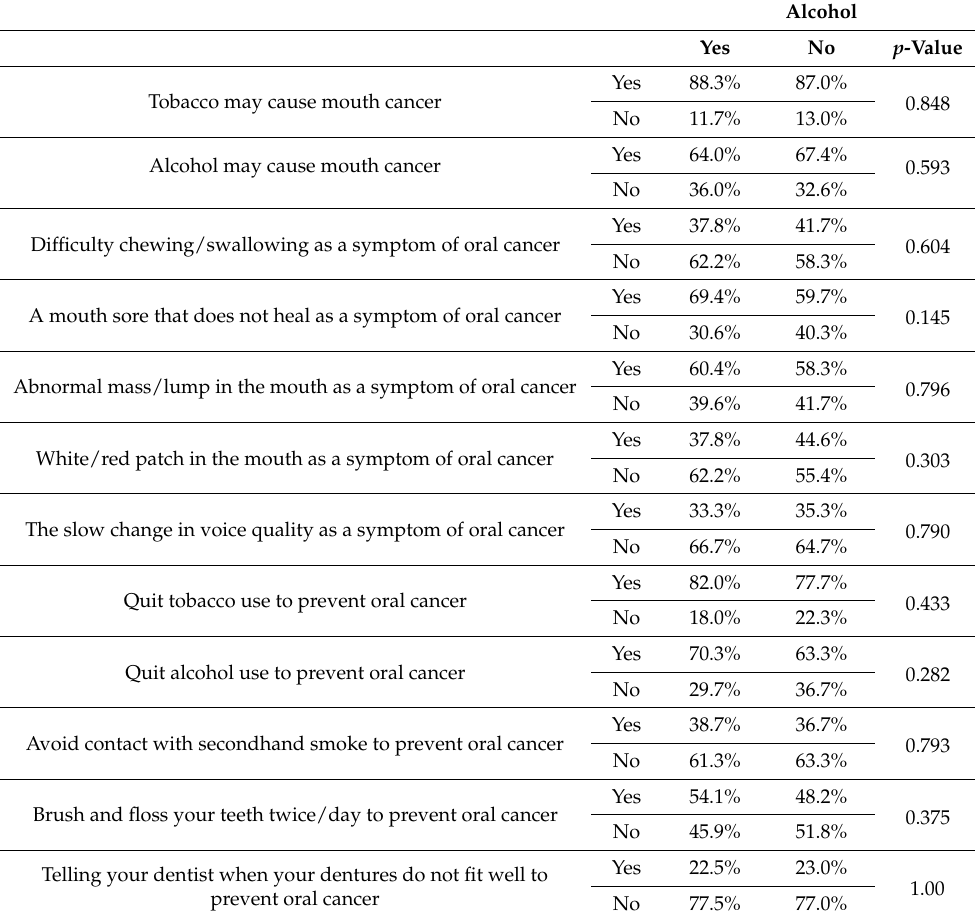
Table 3. Statistical analysis of survey questions according to the current use of alcohol. Bold shows statistical significance ( p <